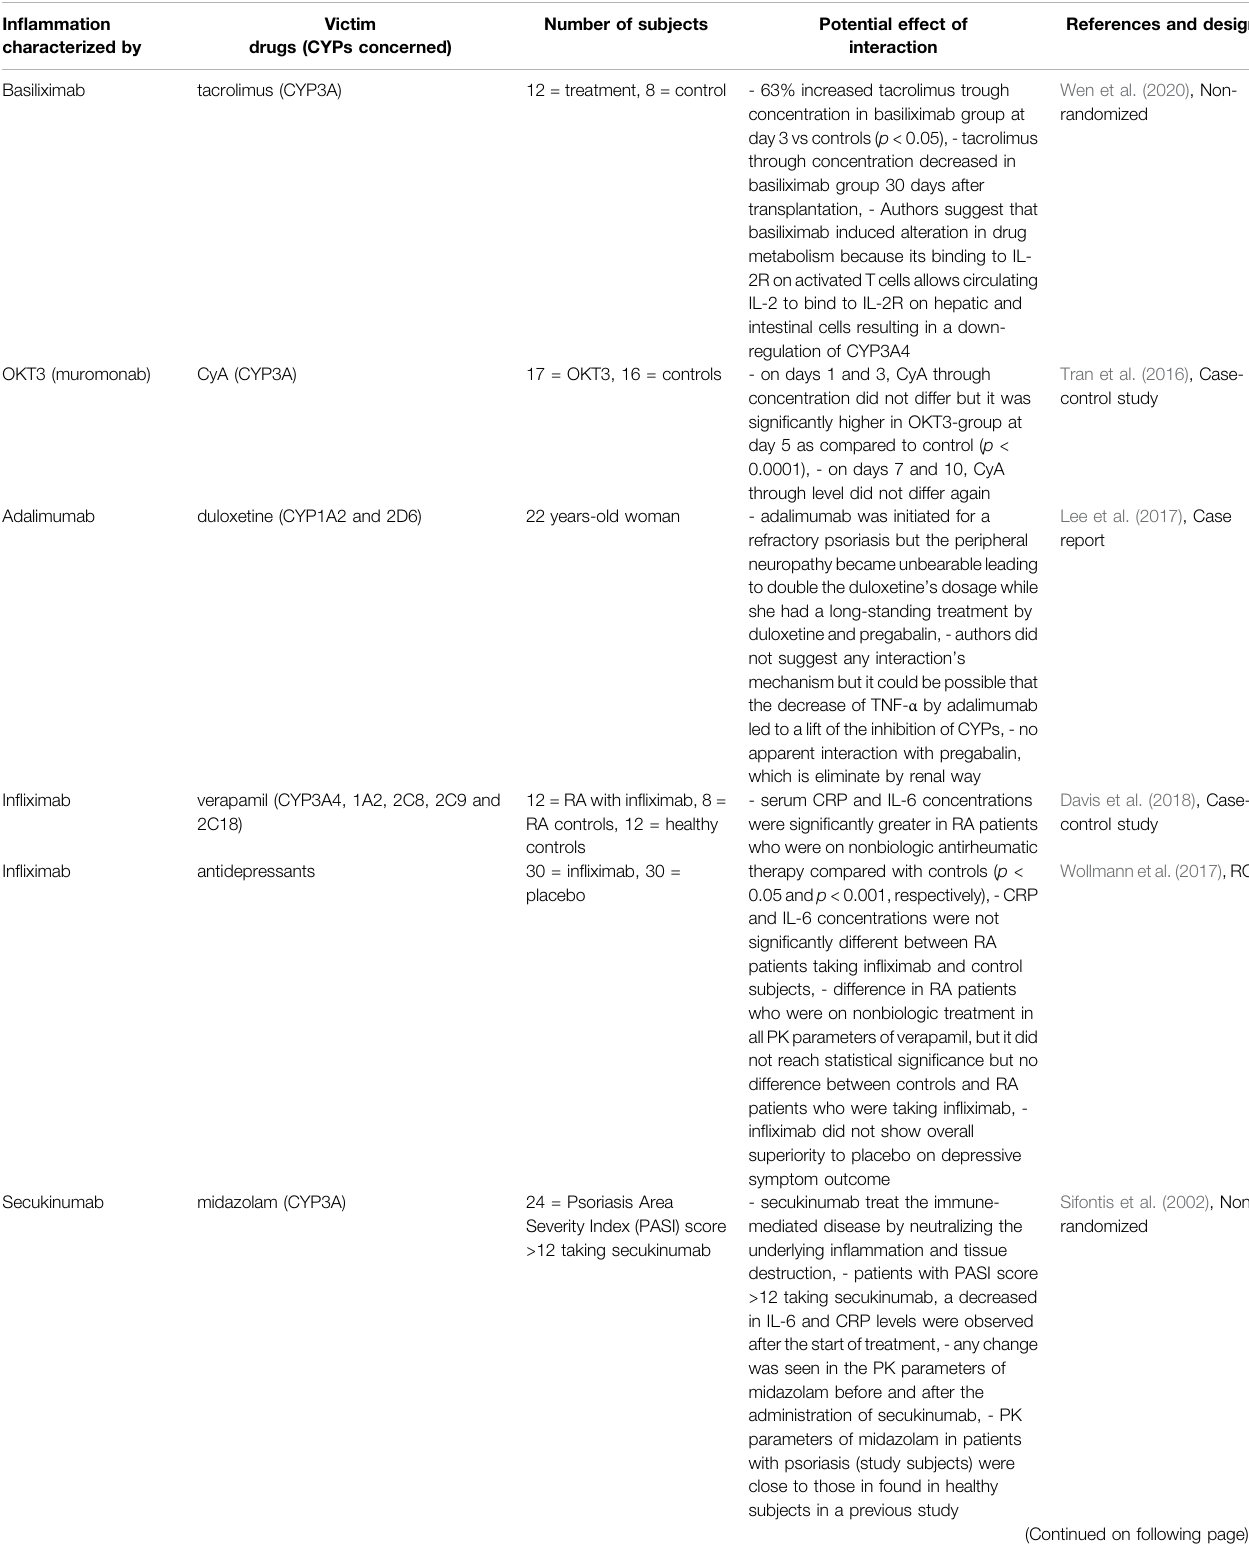
TABLE 14 | Impact of therapies with anti-TNF- α and -mabs on CYP substrates, explained totally or partially by modulation of CYP activity. In fl ammation characterized